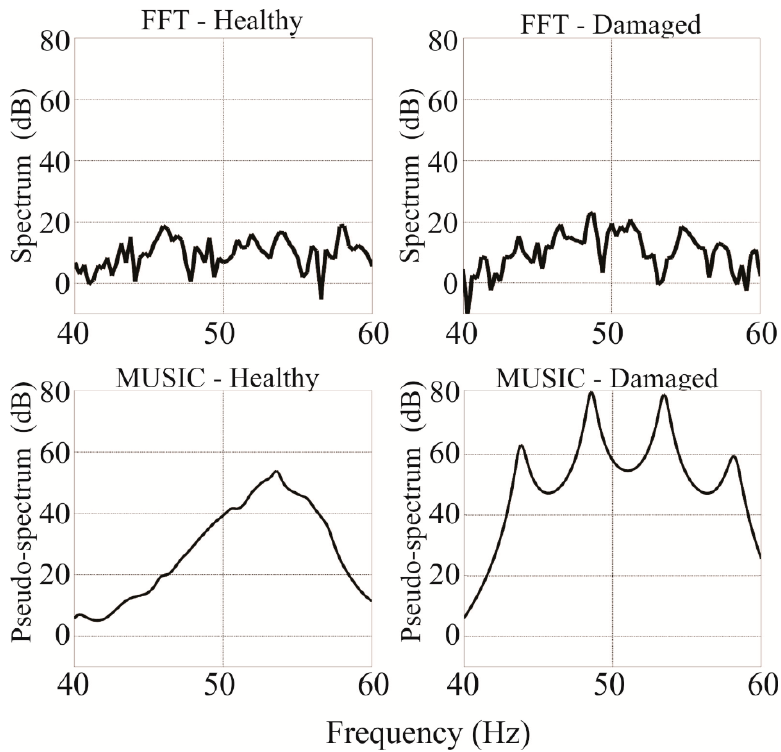
Figure 7. Comparison between healthy bay and damaged bay spectra using fast Fourier transform (FFT) and multiple signal classification (MUSIC) methods.